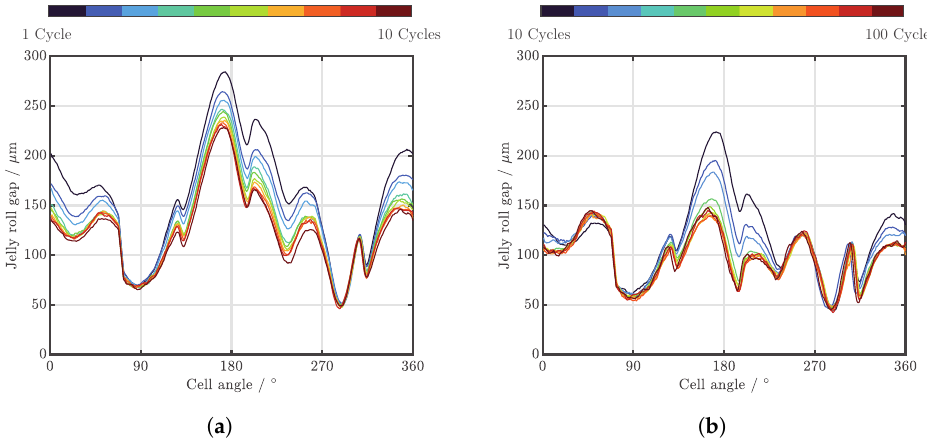
Figure 8. Jelly-roll gaps for the Samsung INR18650-25RM at 100% SOC with smoothed data. ( a ) Jelly- roll gap each cycle for the first 10 cycles. ( b ) Jelly-roll gap each 10 cycles for the first 100 cycles.